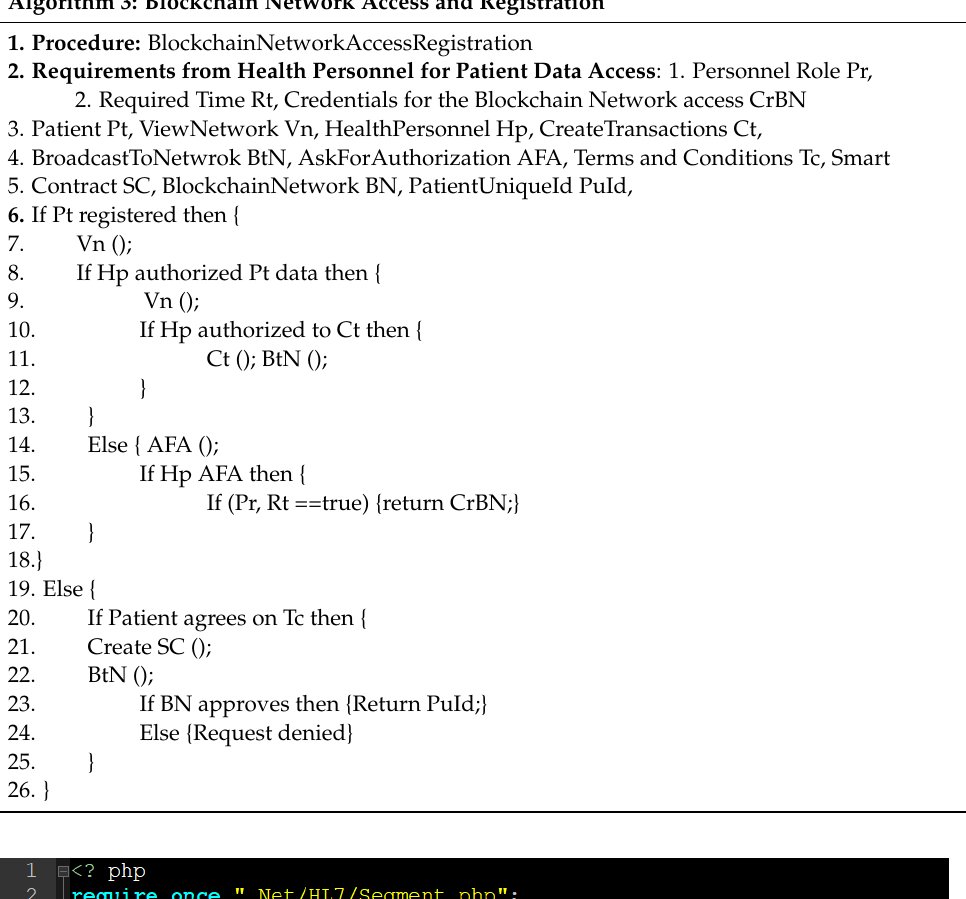
Algorithm 3: Blockchain Network Access and Registration